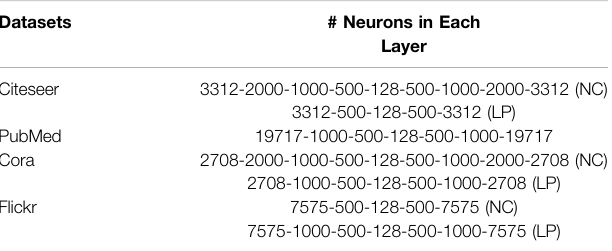
TABLE 7 | Detailed architecture information for datasets ( DANRL-CA-CSM/ Multilevel ). Datasets